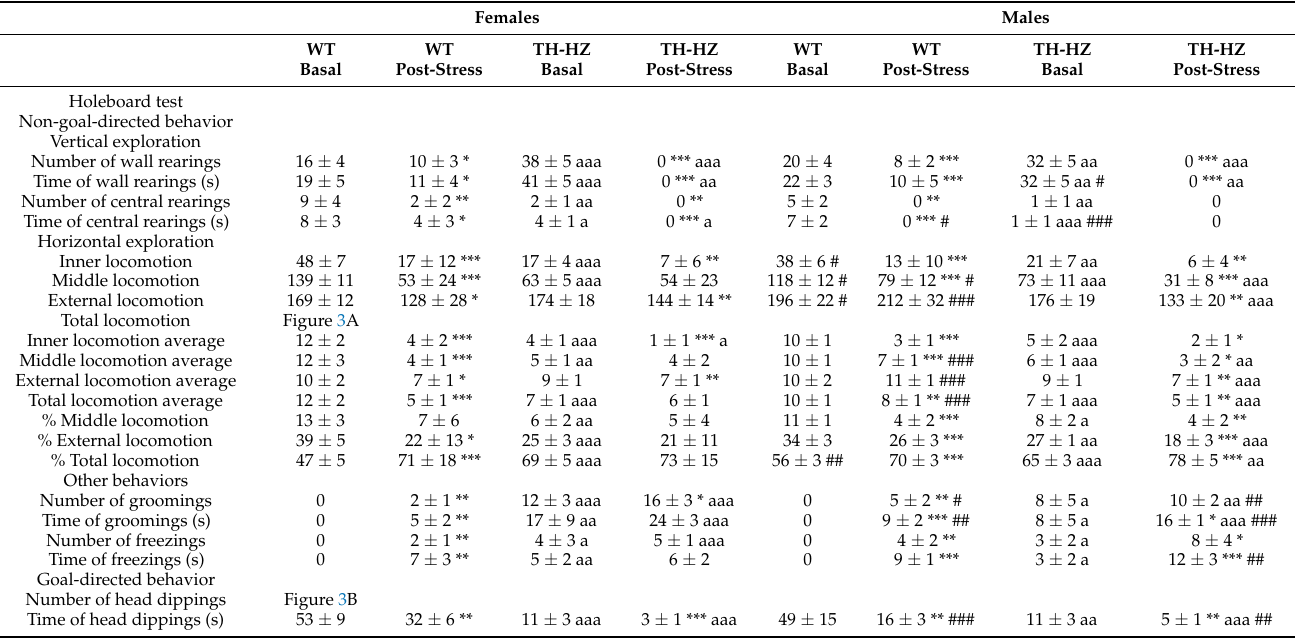
Table 2. Exploratory behaviors evaluated in female and male WT and TH-HZ mice in basal and post-stress